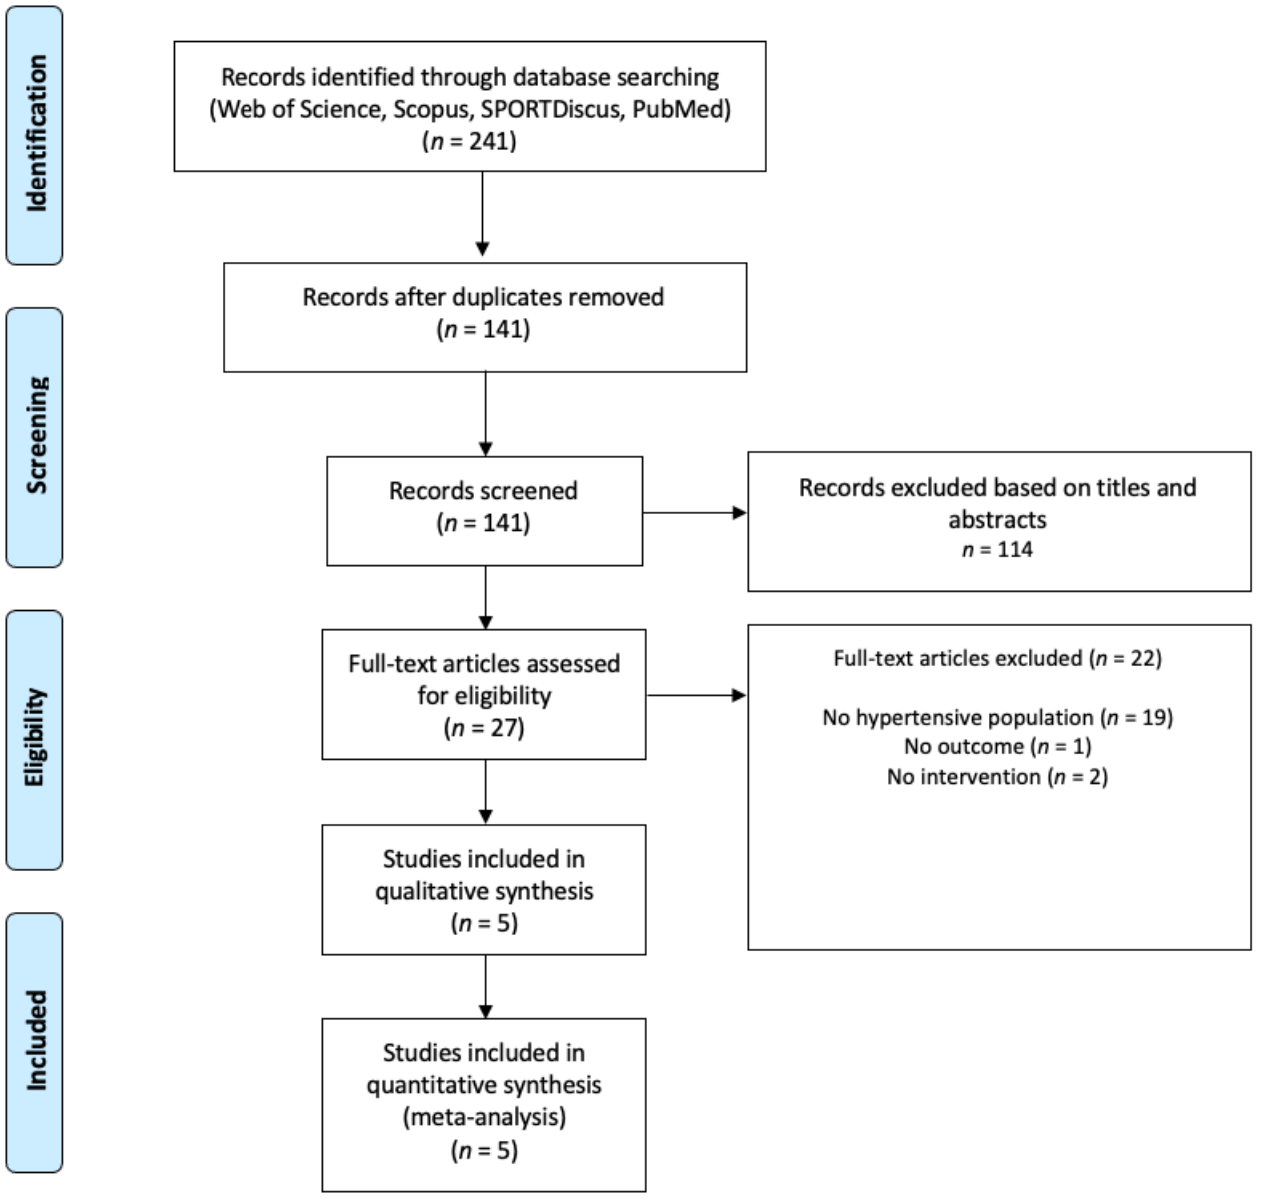
Figure 1. Preferred Reporting Items for Systematic Reviews and Meta-analyses (PRISMA) flow diagram highlighting the selection process for the studies included in the current systematic review.